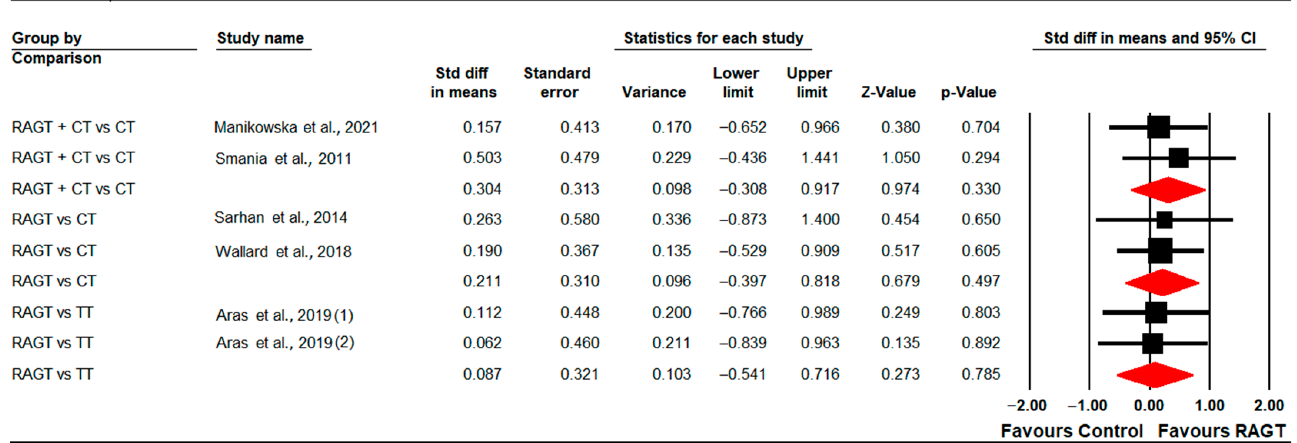
Figure 7. Forest Plot of Cadence (Post-Intervention Assessment) [79,80,82,88,92].